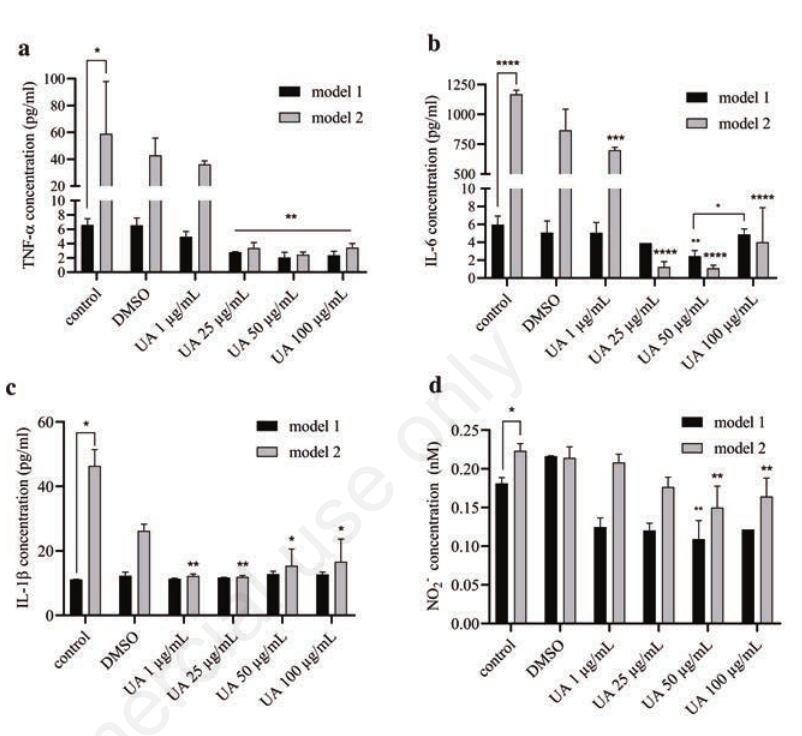
Figure 1. The concentrations of TNF- (a), IL-6 (b), IL-1 (c), and NO2− (d) after UA treatment on noninfected macrophages (model 1) and macrophages infected with α β Mycobacterium avium (model 2). The results are described as mean of ± SD, each per- formed in triplicate; ****p<0.0001; ***p< .001; **p<0.01; *p<0.05.